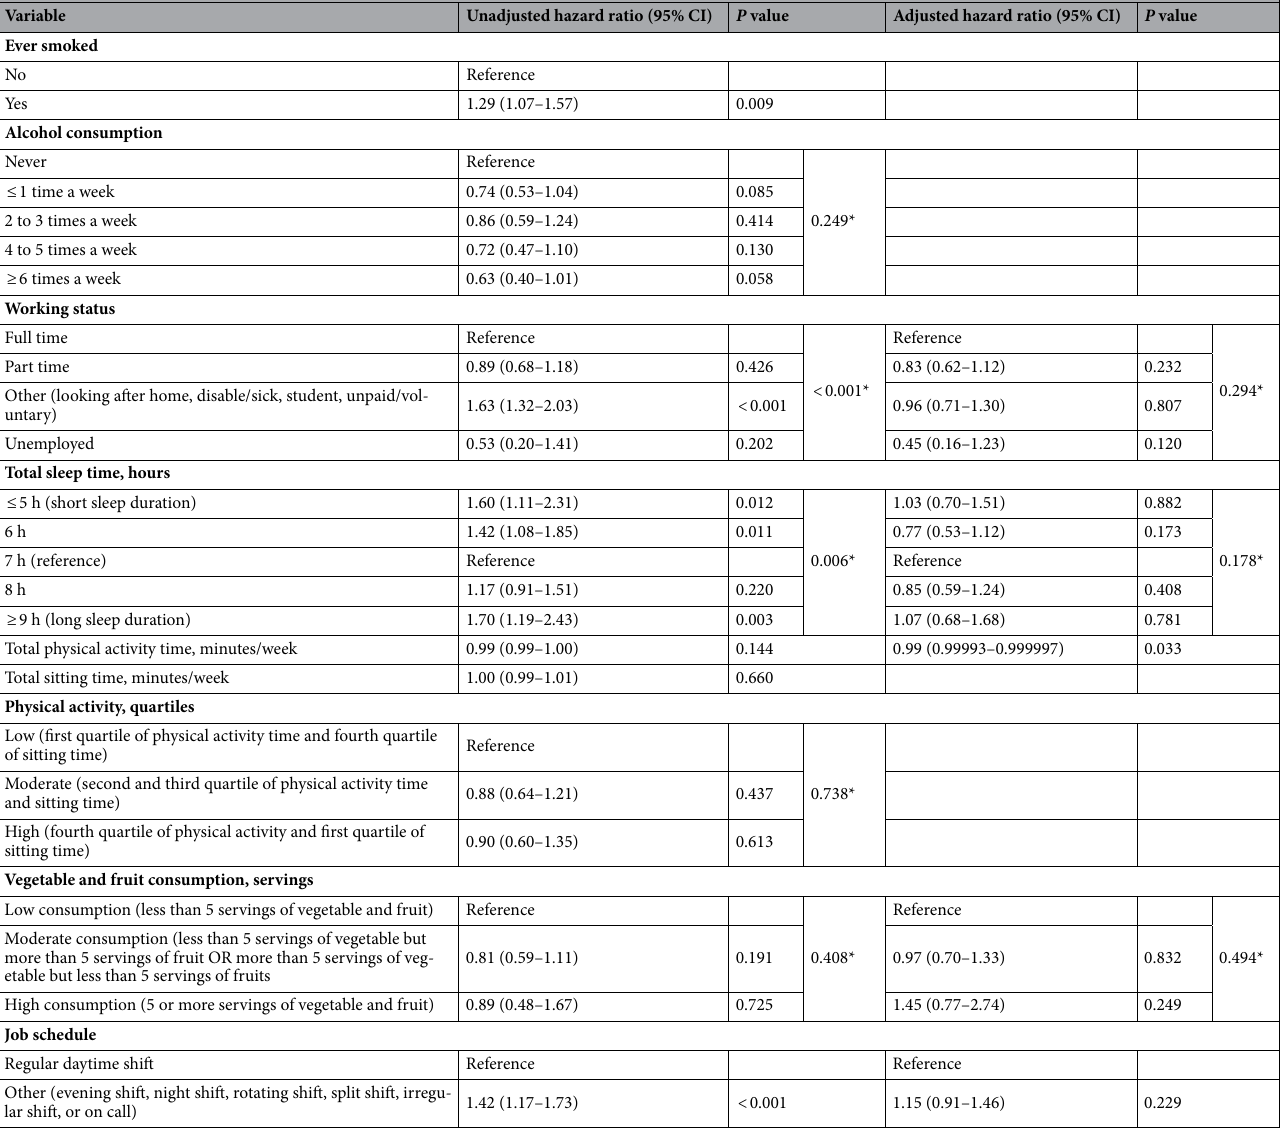
Table 2. Unadjusted and adjusted hazard ratios for the risk factors of hypertension incidence. *Overall effect for categorical variables with multiple